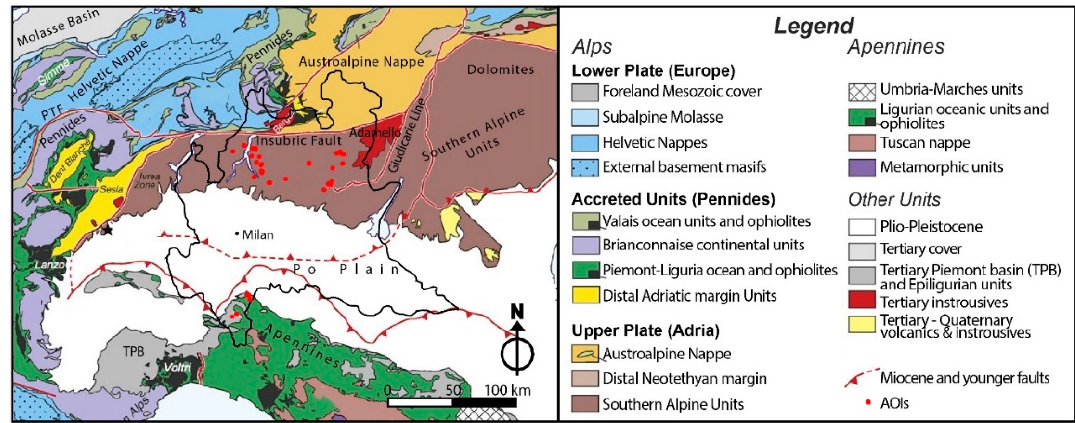
Figure 2. Tectonic Units of Lombardy Region, Italy (the black line shows the border of the Region); modified form Handy et al. [45]. Reproduced with permission from Elsevier, Earth-Science Reviews; published by Elsevier, 2010.